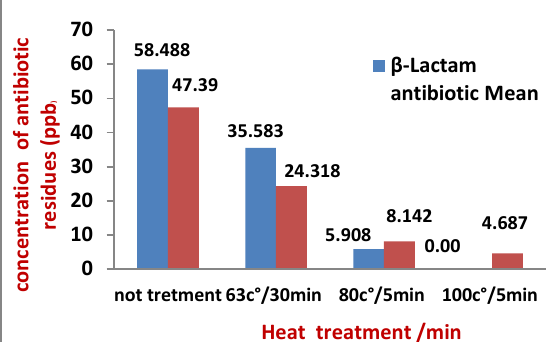
Figure, 2: The percentages of thermal inactivation of the β- lactam and other antibiotics residues in bovine